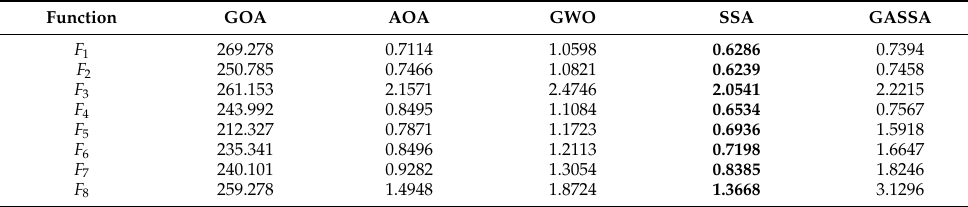
Table 3. Average computation time (in seconds) of 5 algorithms on 8 benchmark